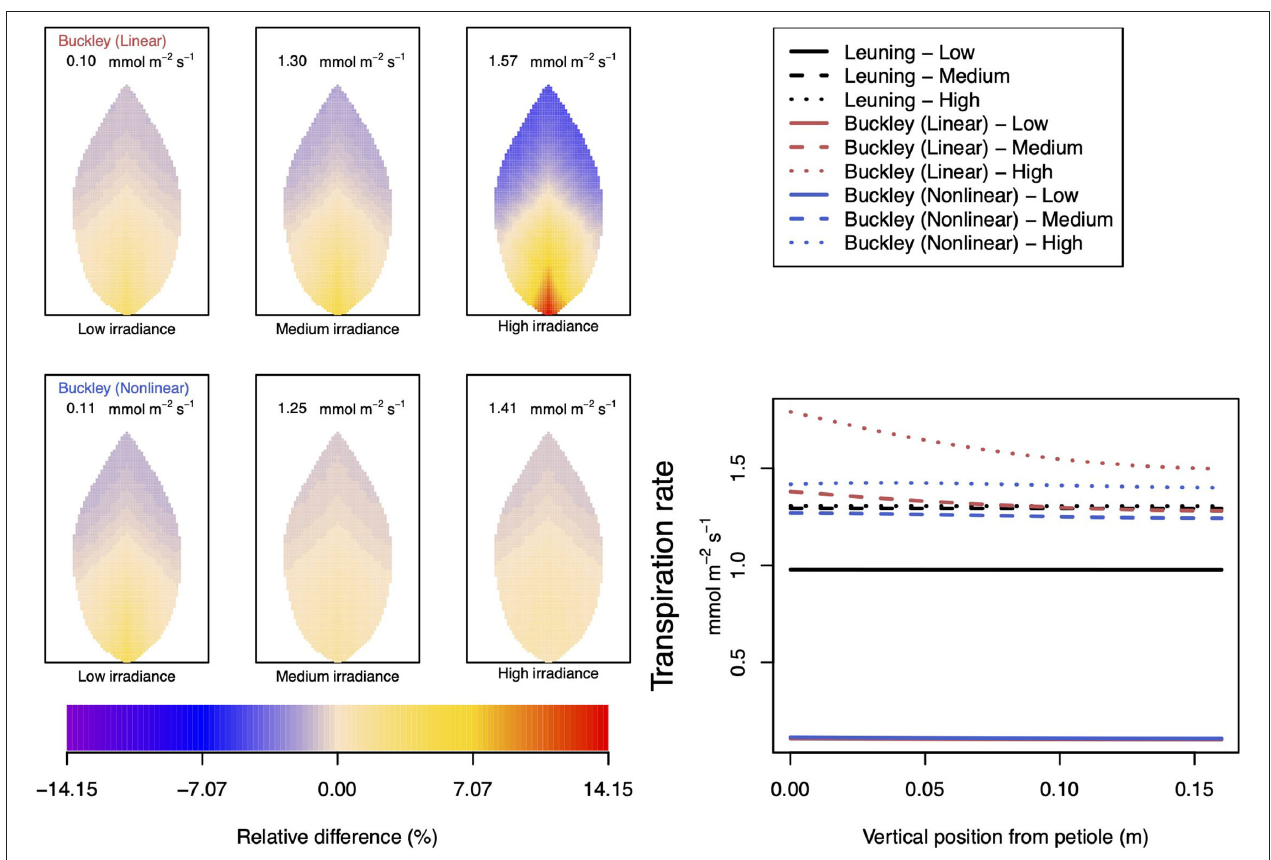
FIGURE 10 | A comparison of predictions of transpiration rate ( − F T ) distributed over the leaf according to the three stomatal conductance models of Leuning (1995) (black lines in right hand figure), linear (Buckley et al., 2003) (top row of panels and red lines in the right hand figure), and nonlinear (Buckley et al., 2003) (bottom row of panels and blue lines in right hand figure). The 2D maps shown are deviations from leaf-area averages. The leaf-area average values of transpiration rates are given at the top of each panel. The three columns (left-to-right) and line styles (solid, dashed, and dotted) show the respective dependencies on the light intensity : low